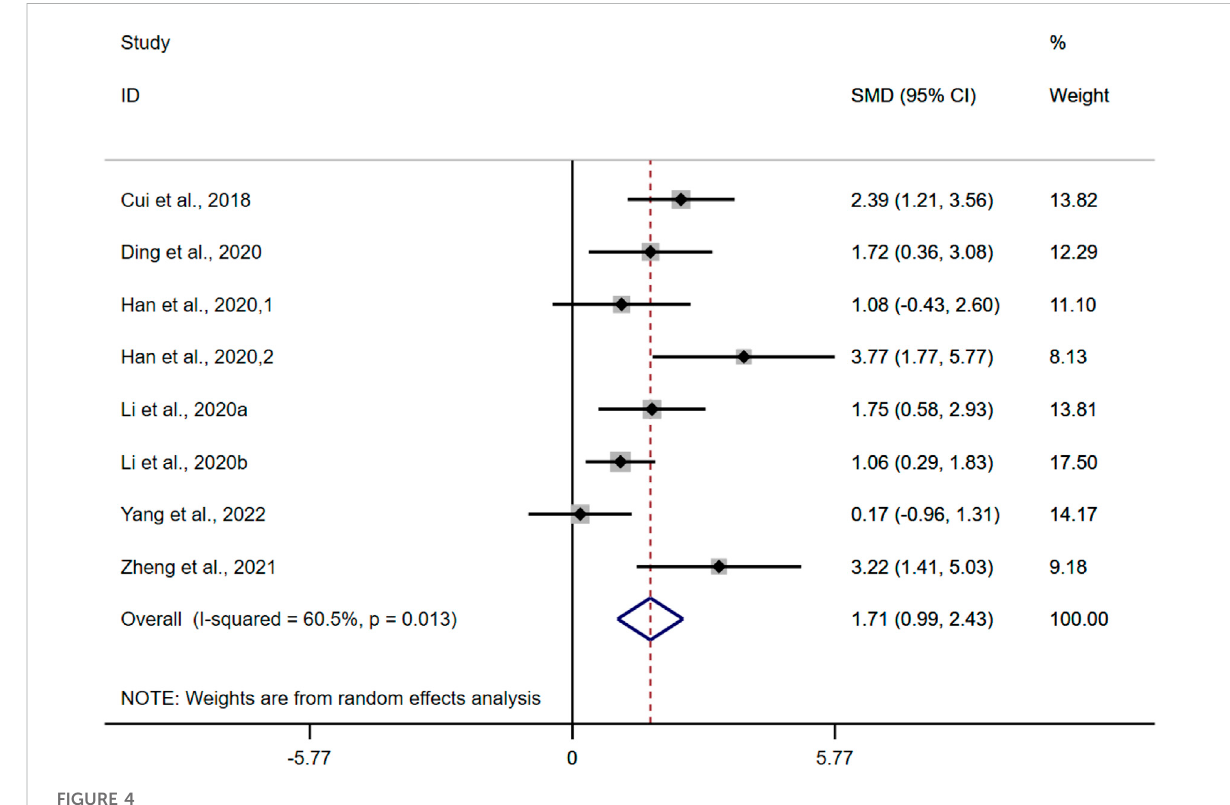
FIGURE 4 Forest plot: effect of berberine on BWC